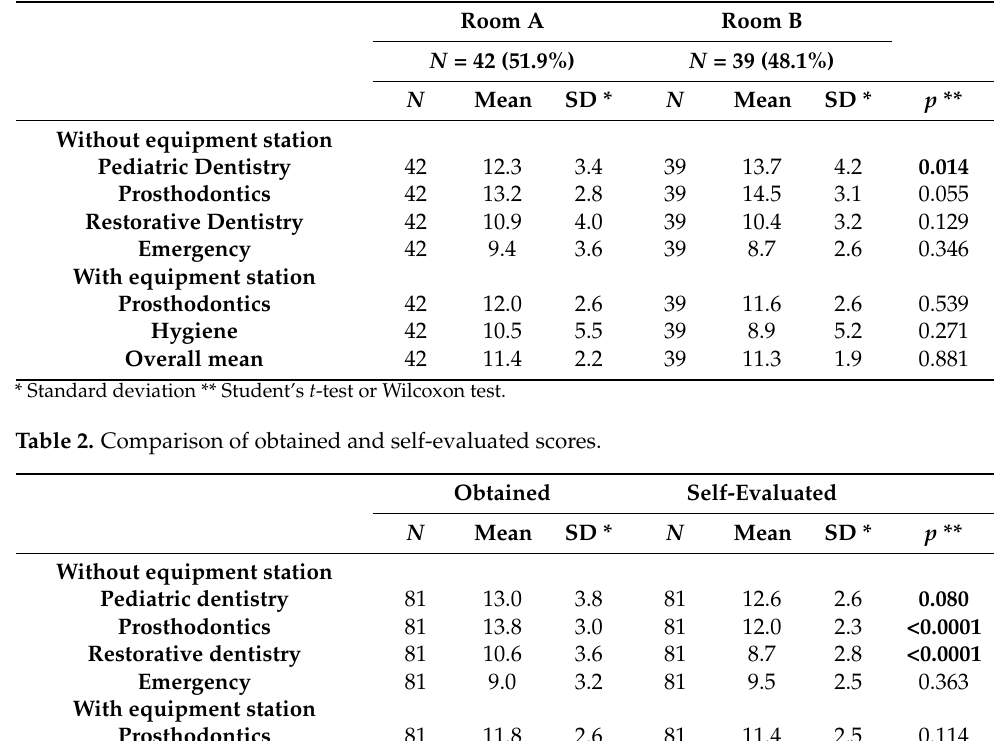
Table 1. Comparison of scores between the two examination rooms.